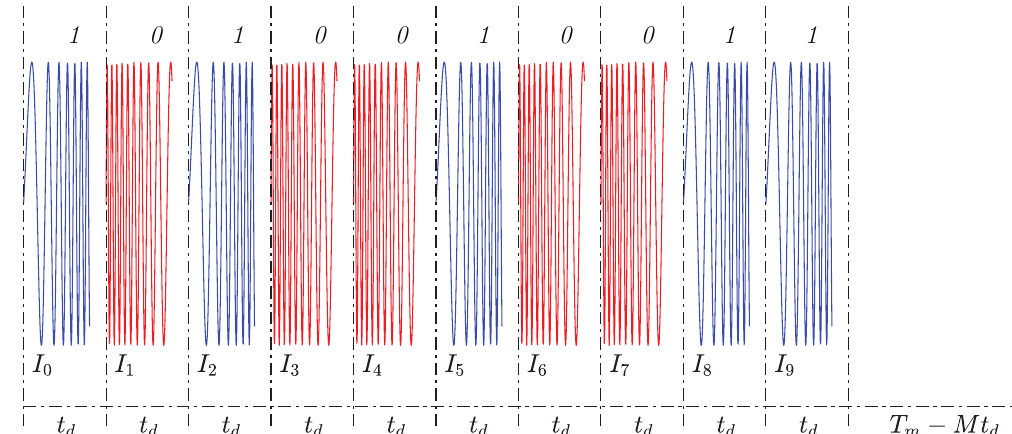
Figure 4. Measurement period of an autonomous vehicle (AV) radar for M = 10. Random signature values are shown on the top: A 1 represents an up-chirp (blue), whereas a 0 represents a down-chirp